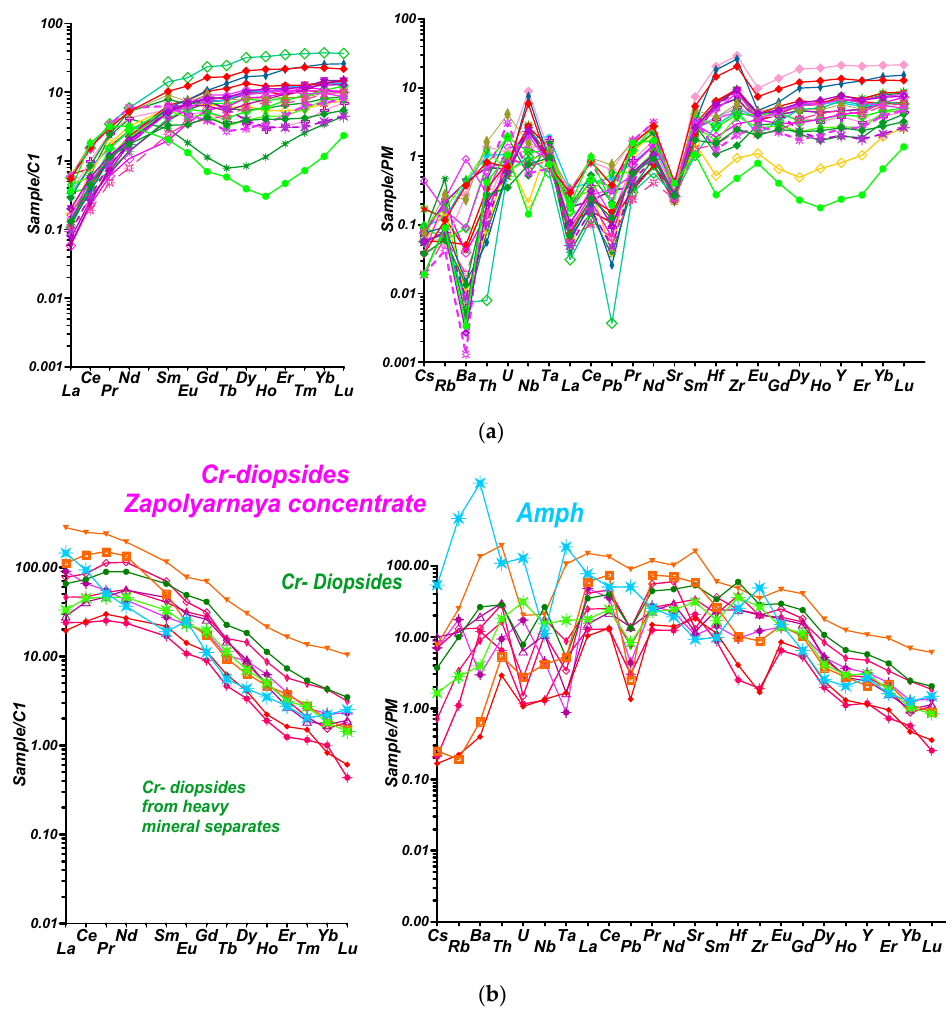
Figure 11. REE and spider-diagrams ( a ) for the Cr garnets, ( b ) from concentrates of Zapolyarnaya pipe. Normalization to chondrite C1 [17] and primitive mantle [30].